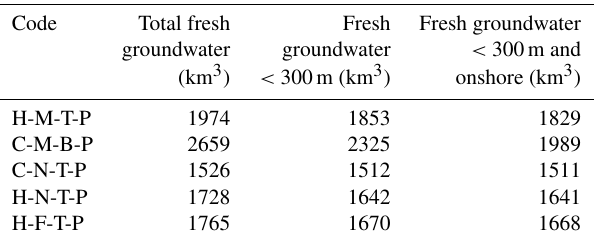
Table 5. End-state FGw volumes for acceptable model